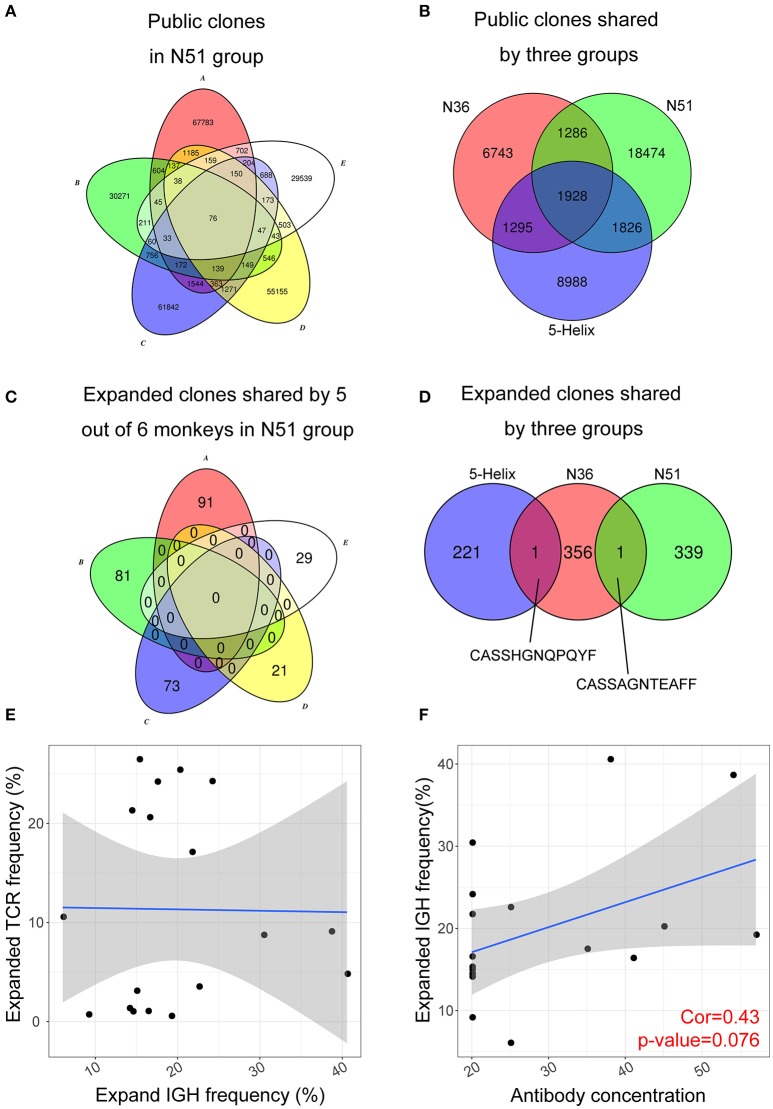
Public expanded TCR clones among vaccination groups. (A) Public non-induced TCR clones shared by 5 macaques in the N51 group (B). Public non-induced TCR clones shared by three vaccine groups. (C) Public expanded TCR clones shared by 5 maracas in the N51 group (D). Public expanded TCR clones shared by three vaccinated groups. The 6th macaques were not plotted for the simplicity of the graph in A and C (E). The correlation between frequencies of expanded IGH clones and expanded TCR clone (F). The correlation between antibody titer and expanded IGH clone frequency.